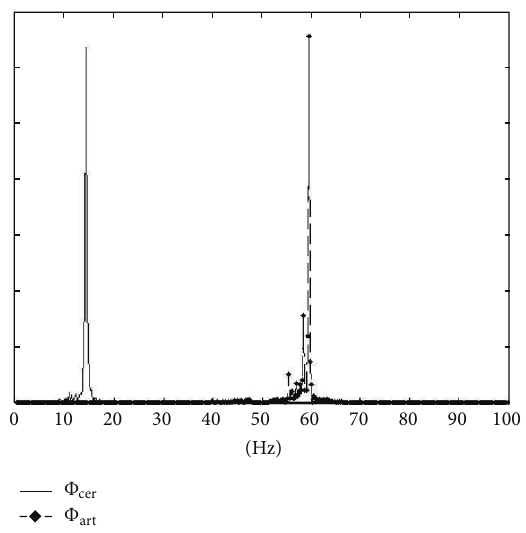
Figure 5: Frequency windows of DAFOP filtering obtained by FIR